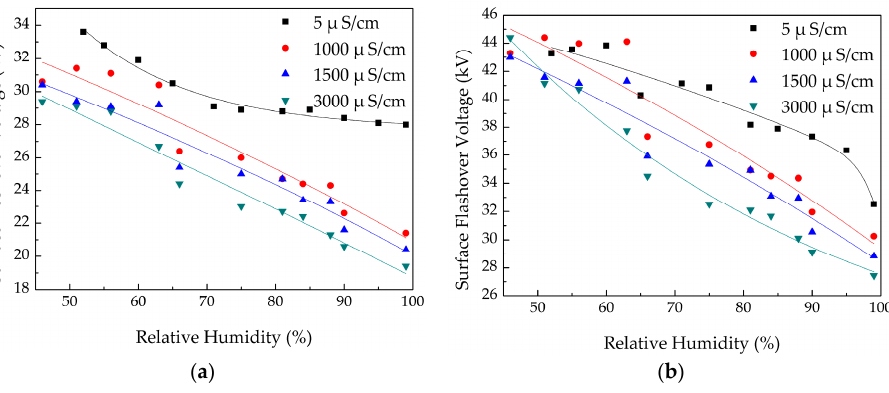
Figure 19. Surface flashover voltage with different conductivity. ( a ) DC( − ). ( b )